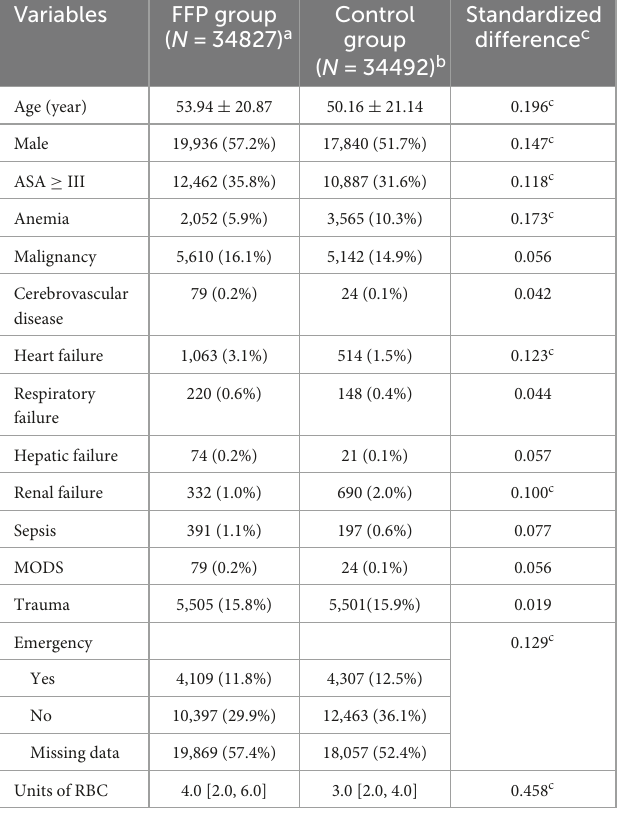
FFP, fresh frozen plasma; ASA, American Society of Anesthesiology; MODS, multiple organ dysfunctionsyndrome;RBC,redbloodcell. a , b Continuous data were expressed as mean ± standard difference (normally distributed data) or median [interquartile range] (non-normally distributed data), and categorical data were describedasnumber(percentage). c Standardizeddifference ≥ 0.1.